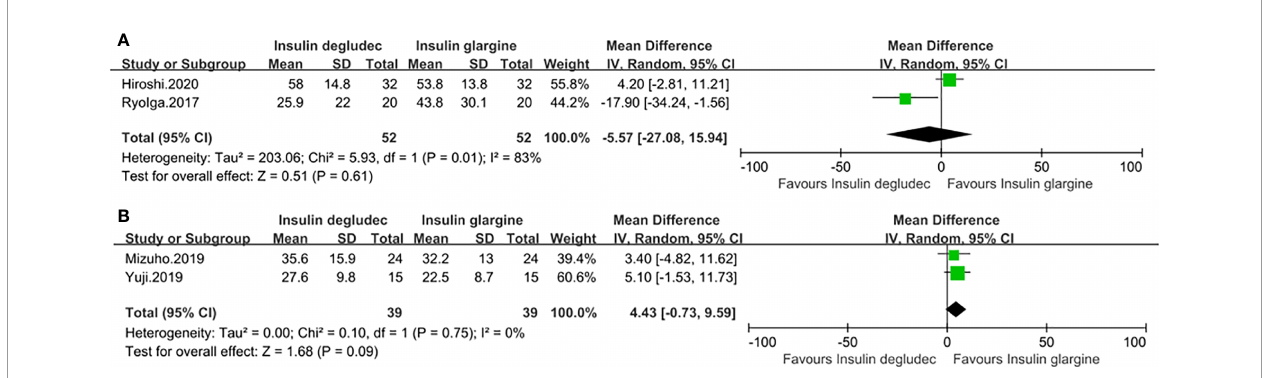
FIGURE 8 | Forest plot for the MODD. (A) MODD in patients with type 1 diabetes; (B) MODD in patients with type 2